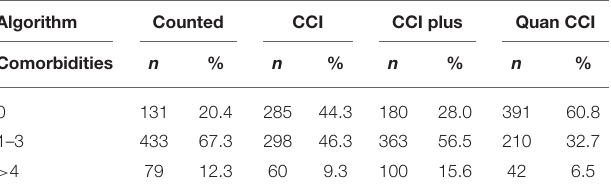
TABLE 2 | Comparison of different algorithms to quantify co-morbidities. Algorithm